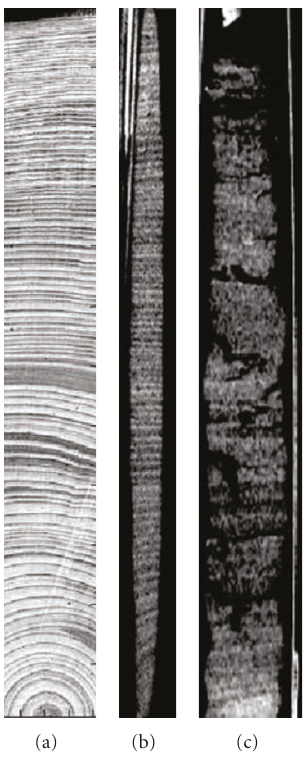
Figure 1: Wood-core image examples: (a) Spruce image example from the Grissino Mayer database. (b) Good quality populus image sample. (c) Low quality populus image with significant interring variations and structural artifacts. Figure 1(a) obtained from (http://web.utk.edu/ ∼ grissino/Site/gallery/galleries/ Tree%20Ring%20Gallery%201/images/pinaleno%20spruce.jpg) and Figures 1(b) and 1(c) obtained from Oak Ridge National Laboratory populus database (see text for